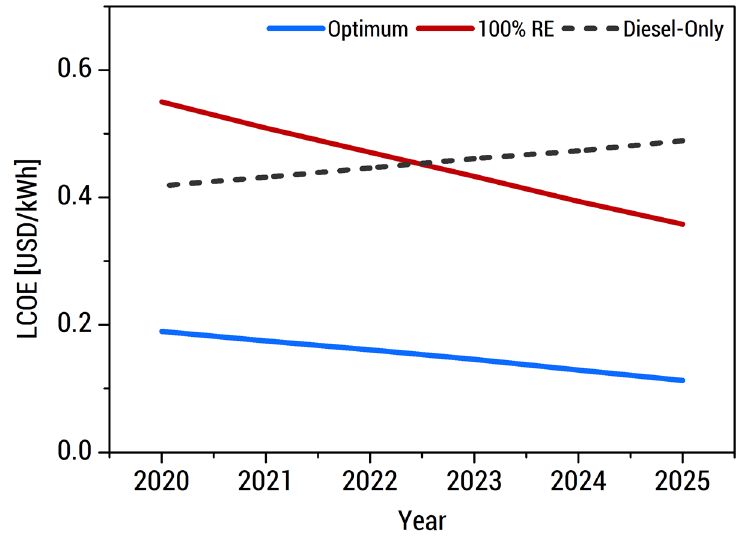
Figure 6. Calculated future LCOE of the optimum system and 100% RE system in comparison with the TCGR within the analysis period of 2020 to 2025. The LCOE of the optimum system is already lower than the diesel-only system in 2020, while the 100% RE system yields a lower LCOE than the diesel-only system in 2023.